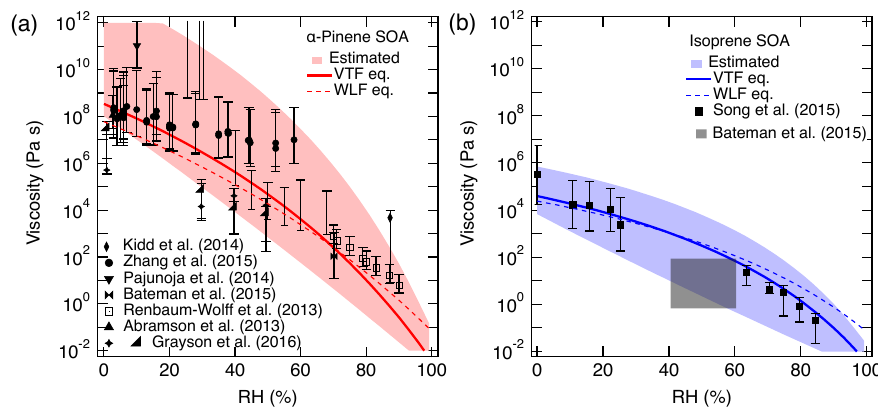
Figure 4. Comparison of the measured and predicted viscosity of (a) α -pinene SOA and (b) isoprene SOA at 295K as a function of RH. The solid lines represent base simulations with the VTF equation, while the dotted line represents viscosity predicted using the WLF equation. Parameters are the glass transition temperature of dry SOA ( T g , org ) , fragility ( D) , hygroscopicity ( κ) , and the Gordon–Taylor constant ( k GT ) : (a) 278.5K, 0.1, 10, and 2.5; (b) 255K, 0.1, 10, and 2.5. The shaded regions were determined by varying these parameters. (a) Upper (lower) limit: T g , org = 300K (278.5K), κ = 0.1 (0.1), D = 20 (10), k GT = 2.5 (2.0); (b) upper (lower limit): T g , org = 255K (255K), κ = 0.10 (0.15), D = 15 (8), k GT = 2.5 (4.0). Panel (a) : Renbaum-Wolff et al. (2013) data represent viscosity for the water-soluble portion of SOA; Grayson et al. (2016) data in panel (a) represent two different mass loadings (121µgm − 3 ; 520µgm − 3 ) . Panel (b) : the gray box represents estimated viscosity for isoprene SOA based on the bounce measurements of Bateman et al.